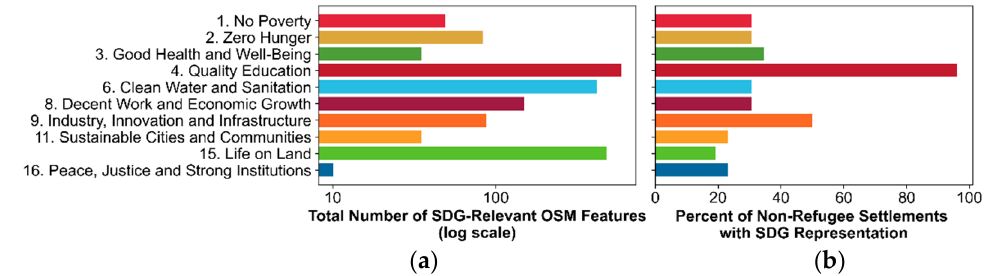
ISPRS Int. J. Geo-Inf. 2021 , 10 , x FOR PEER REVIEW Figure 12. Distribution of SDG-relevant OSM features by ( a ) total number of features (logarithmic scale) and ( b ) percentage of non-refugee settlements with representation by at least one SDG-relevant OSM feature.